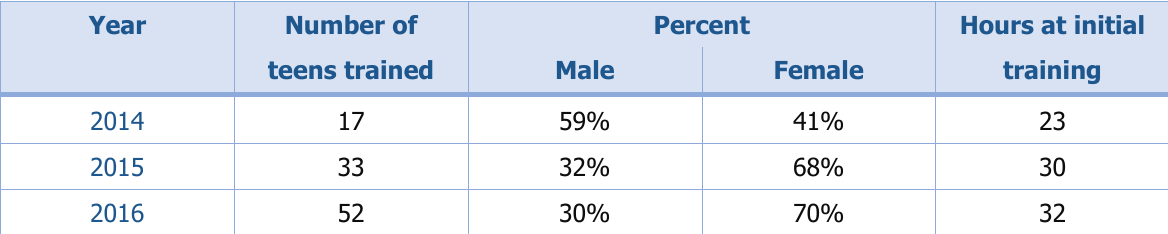
Table 5. Number of Teen Teachers Trained and Hours of Service Each Provided to the Program